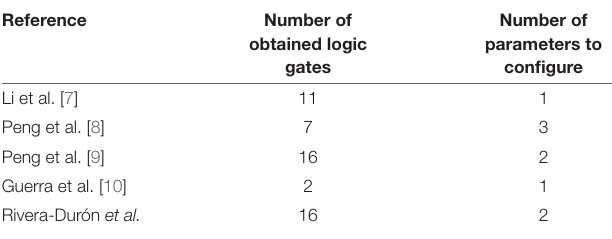
TABLE 4 | Comparative frame among several approaches already presented and our proposal of DLG.